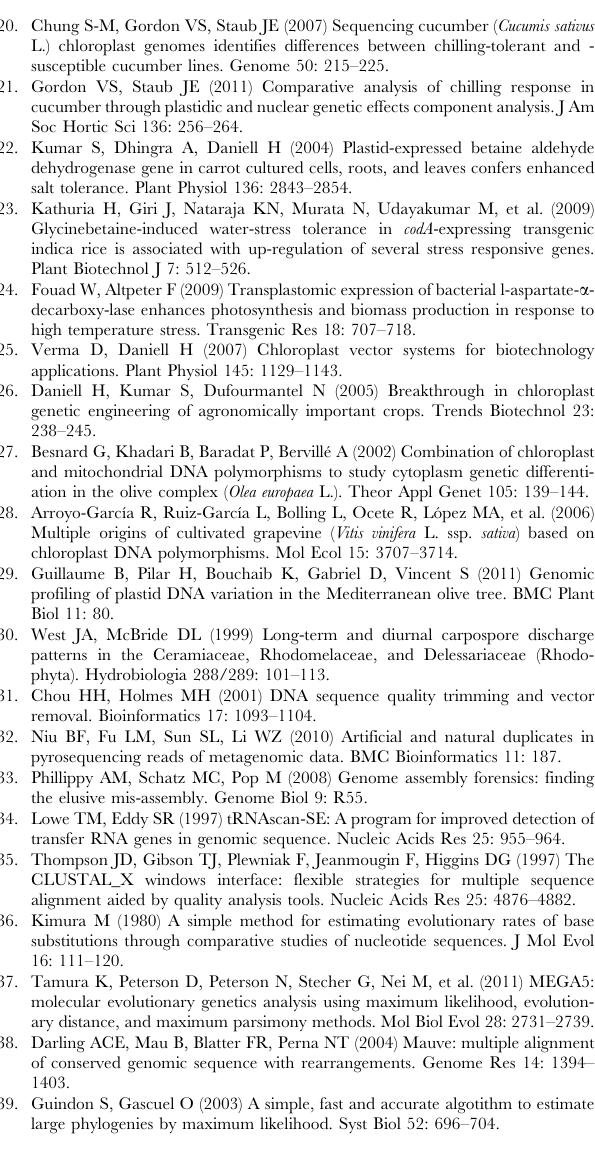
Table S1 Primers used for gap filling and assembly validation. Table S2 Plastid and cyanobacterial genomes used in the gene content comparisons and the phylogenetic studies. Table S3 Gene content comparisons between plastid